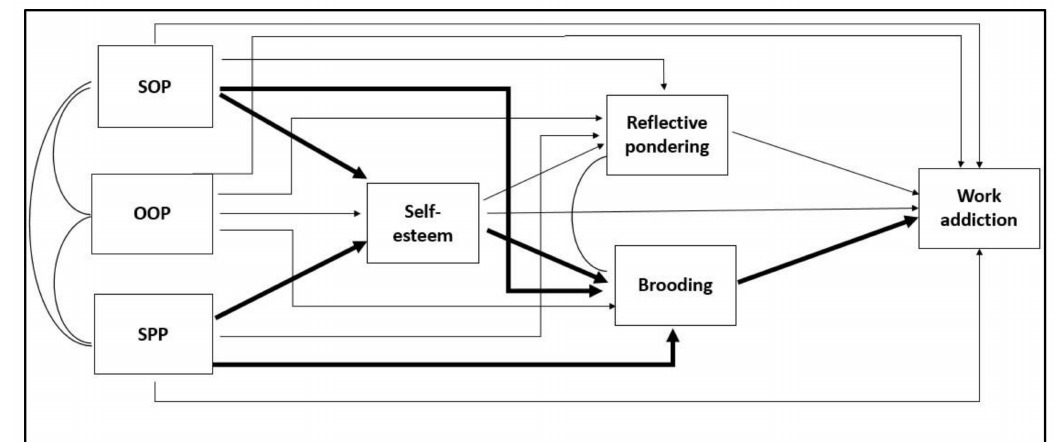
Figure 1. A theoretical model of the mediating e ff ect of brooding between (i) self-esteem and work addiction, (ii) self-oriented perfectionism and work addiction, and (iii) socially prescribed perfectionism and work addiction. Notes: The arrows representing the study’s hypotheses are emboldened. SOP = self-orientedperfectionism, OOP = other-orientedperfectionism, andSPP = socially prescribed